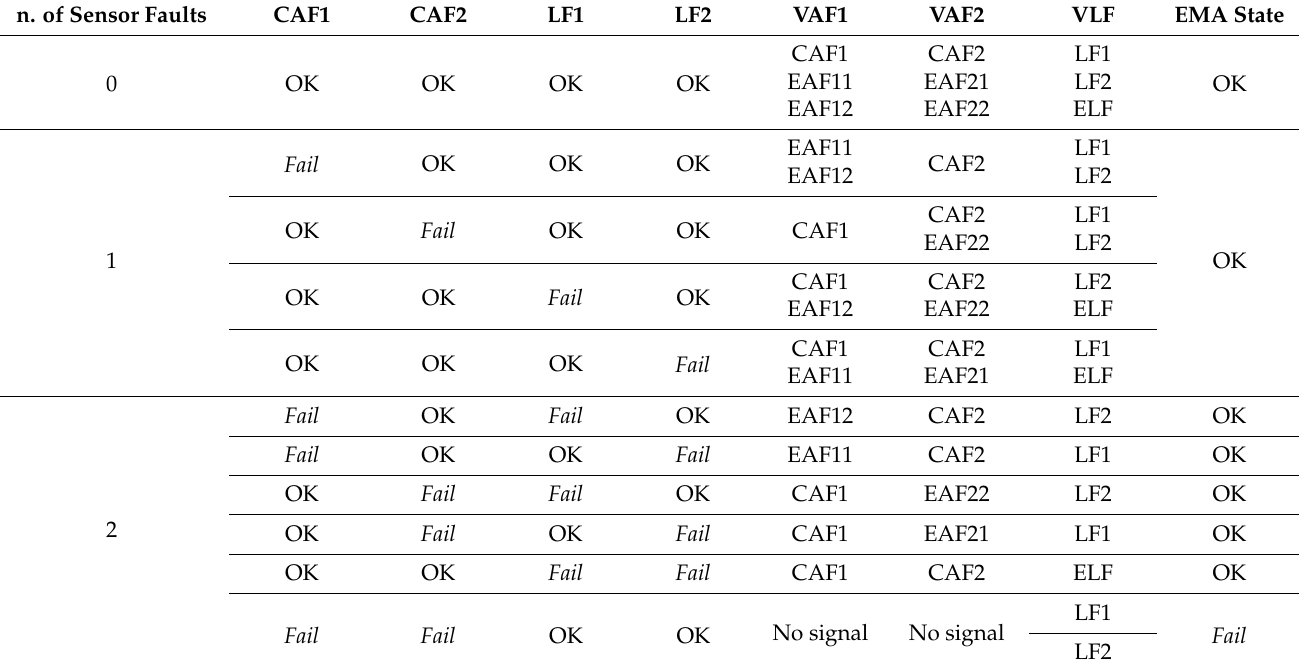
Table 3. Motion Monitor: EMA operative states resulting from position sensors faults. n. of Sensor Faults